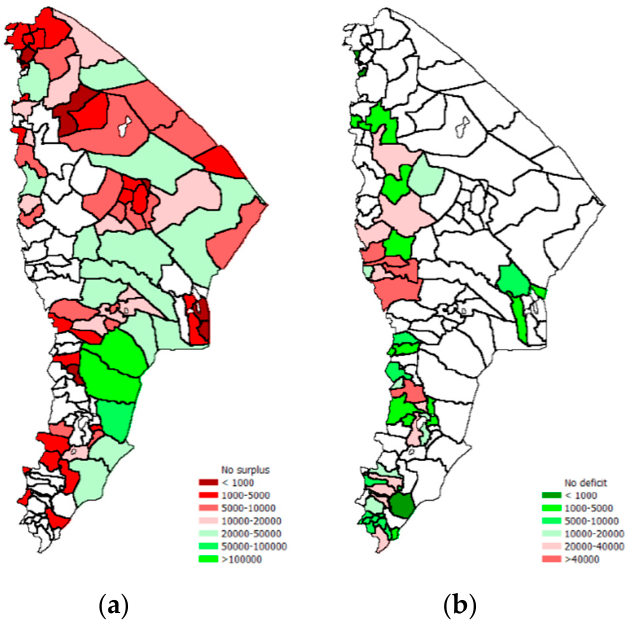
Figure 11. Surplus (panel a ) and deficit (panel b ) of annual fodder supply expressed in TLU equivalents after migration (scale 1:7,200,000).